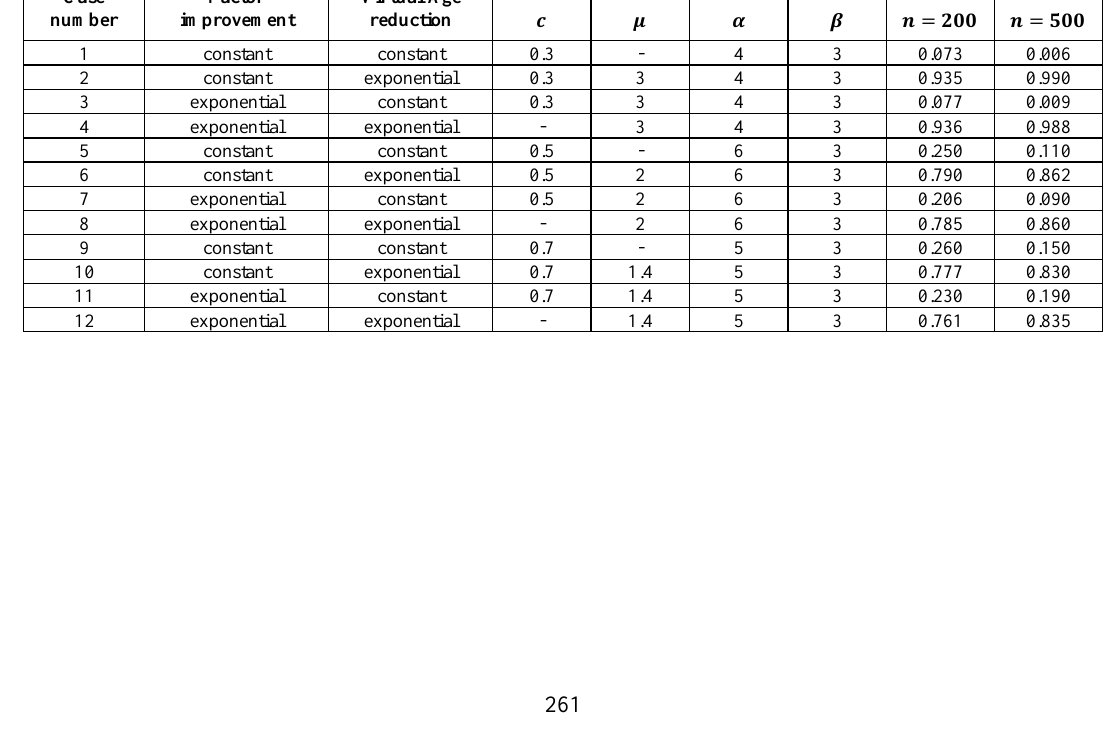
Table 2. Proportion of AIC for the test of CME and EME models for different values of parameters and n . Case Factor number